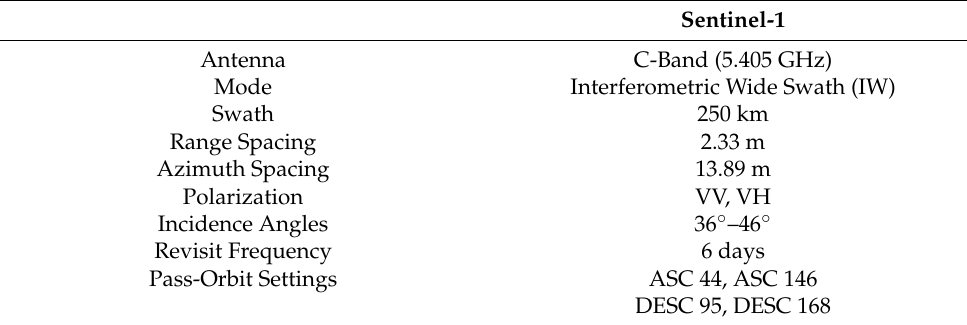
Table 1. Selected features of the Sentinel-1 data.